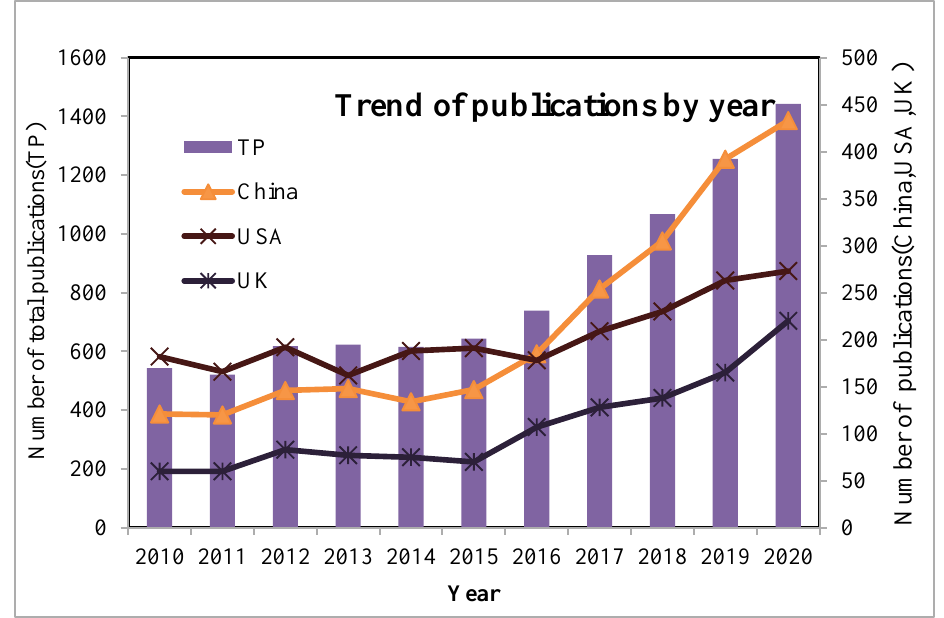
Figure 1. Number of publications (China, USA, UK) related to SCM.